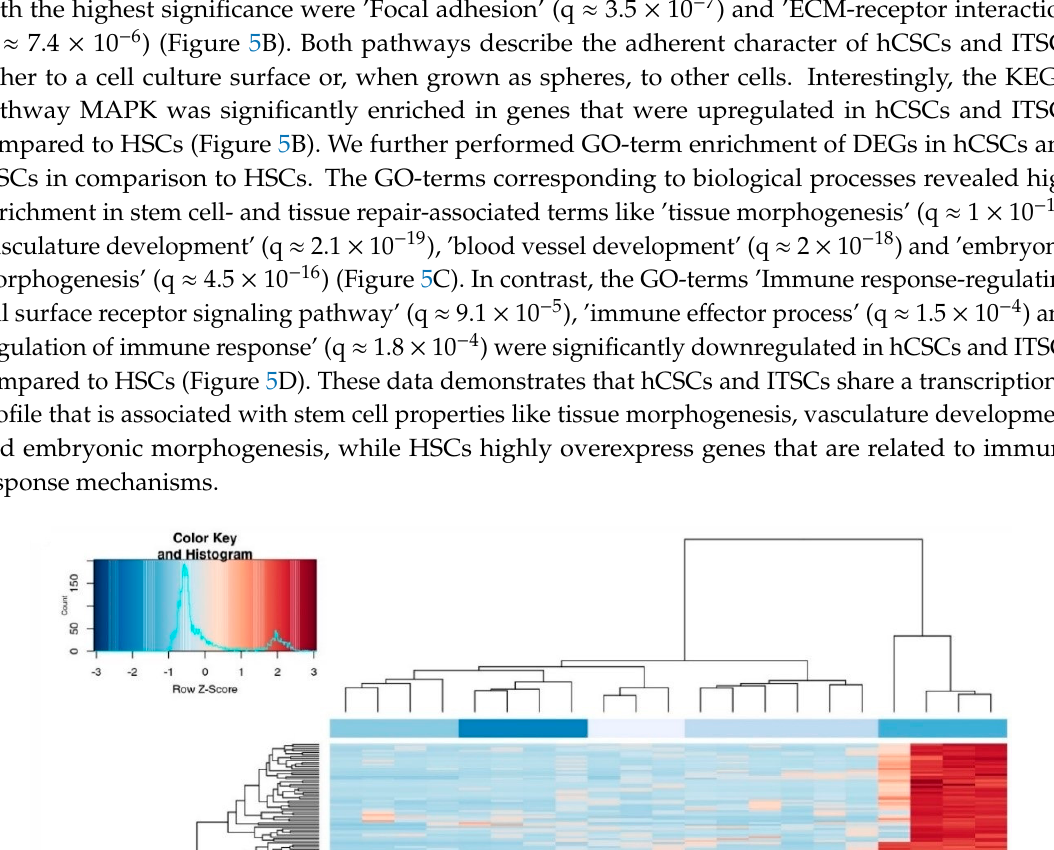
Figure 3. Comparison of global gene expression profiles of adult stem cell populations from different sources. ( A ) Principal component analysis reveals that all cell populations cluster independently. ( B ) The sample distance matrix reveals great differences between hematopoietic stem cells (HSCs) and other adult stem cell populations.